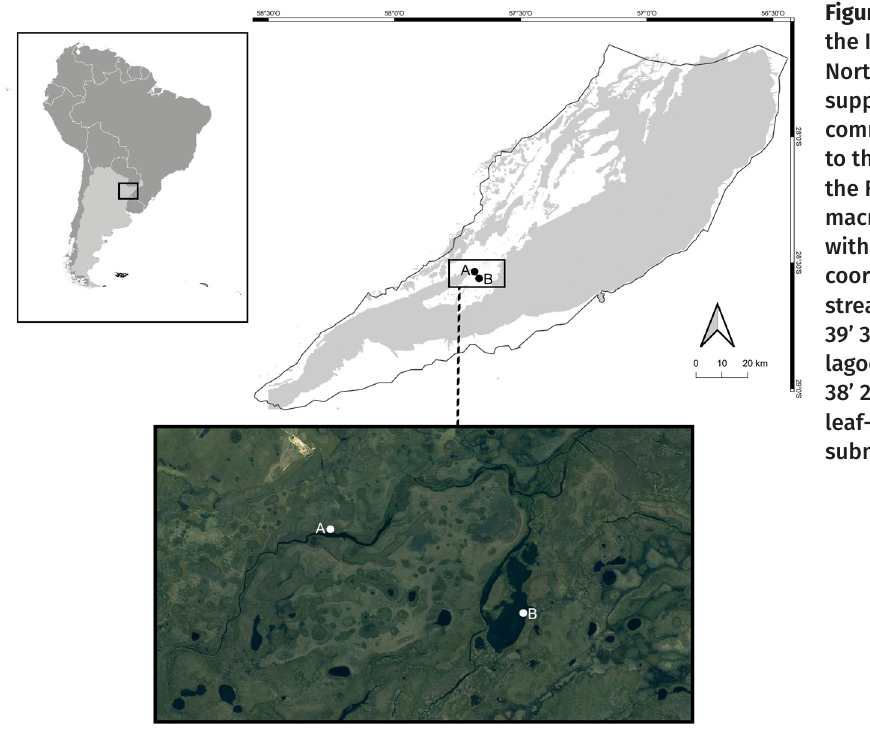
Table I. Physicochemical variables from the studied wetlands of the Iberá System in growth (G) and decline (D) period of the macrophyte populations. Transparency was measured as Secchi disc